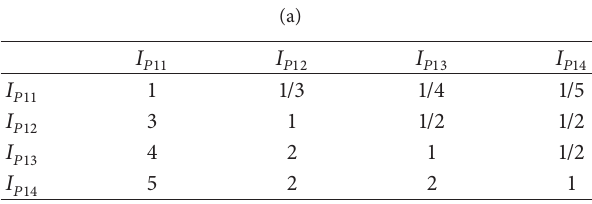
Table 6: Product index judgment matrix of tertiary indicators rela- tive to secondary indicators.